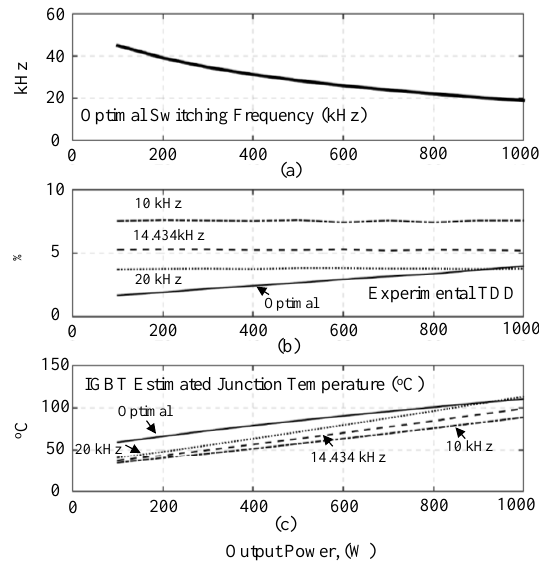
Figure 11. Optimal switching frequency, experimental TDD, and IGBT junction temperature for different switching frequencies, ( a ) optimal switching frequency in kHz; ( b ) the experimental TDD of the output current under different switching frequencies; ( c ) estimated IGBT junction temperature under different switching frequencies.